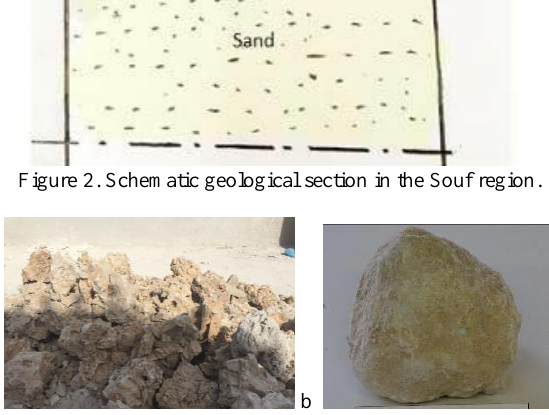
Figure 3. a. ‘Desert Rose’ stone. b. Tafza stone.